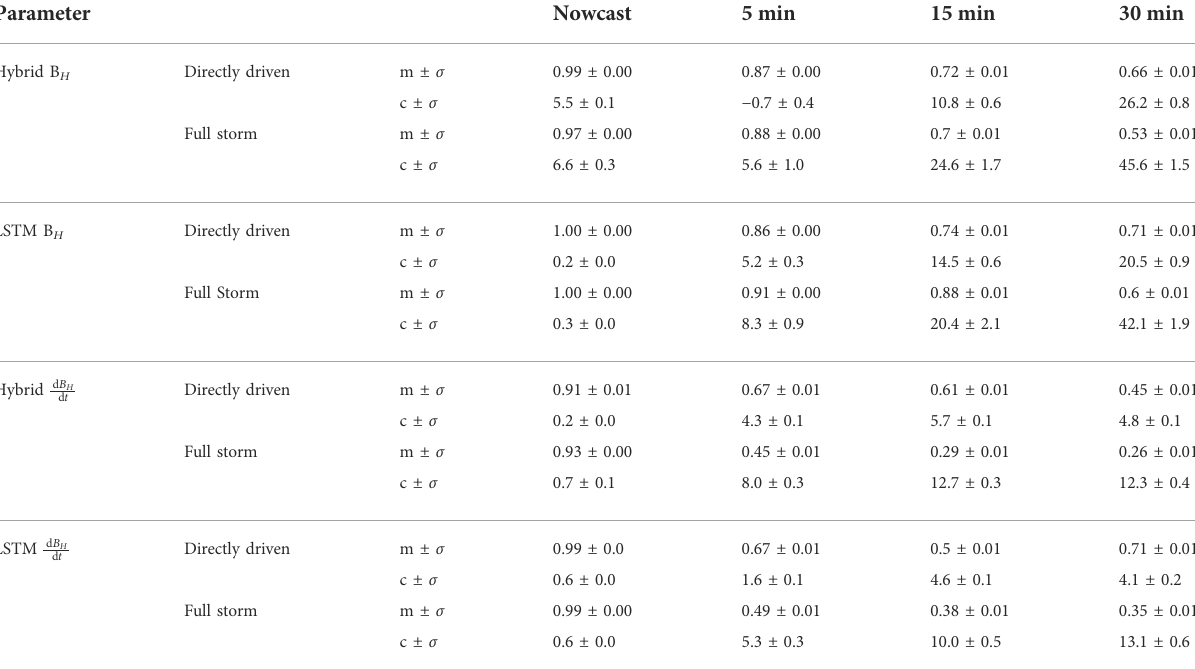
TABLE 4 Gradient, m , and intercepts, c , for best fi t lines for now- and forecasts at LER as shown in Figure 5. σ is the standard deviation of the best fi t gradient and intercept parameters derived from the covariance matrix of the least squares fi